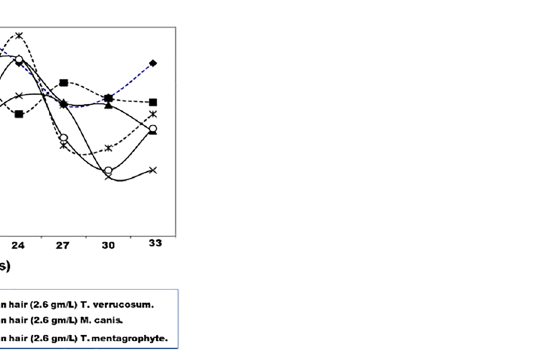
Figure 5. Correlation curve illustrates the effect of keratin source and incubation time on in vitro production of exo-keratinases (keratin unit/ml) by M. canis , T. verrucosum , and T.